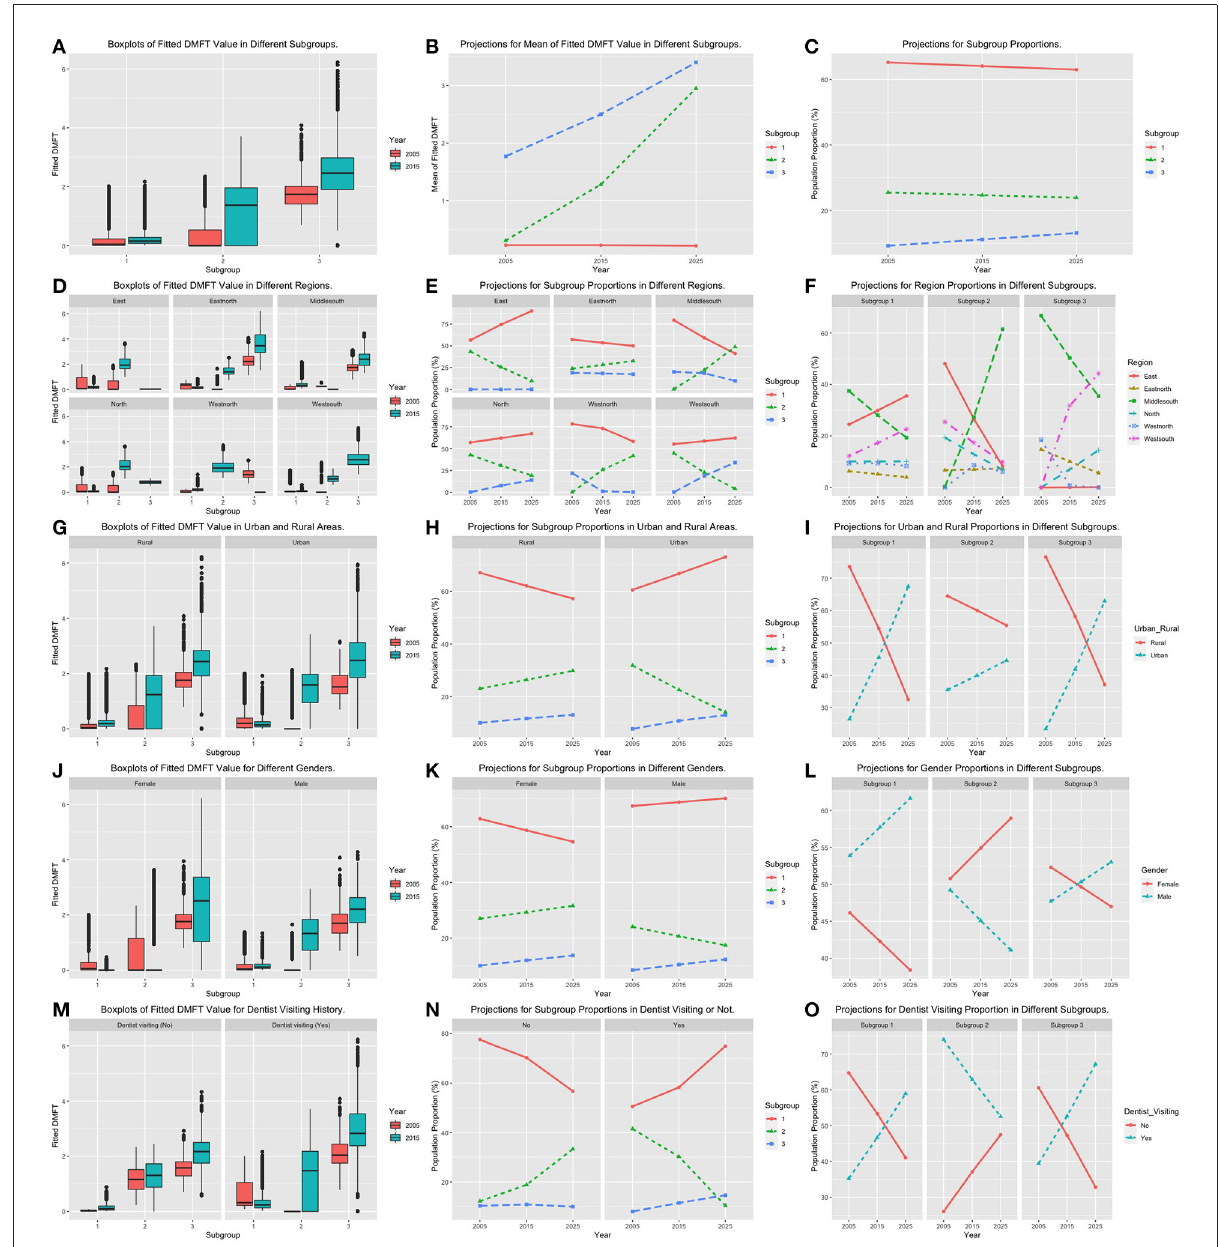
FIGURE1 Boxplots for fitted DMFT, projection plots for subgroup proportions and risk factor category proportions. The first column (A,D,G,J,M) summarizes the boxplots of fitted DMFT values within subgroups by adjusting different risk factors. The second column (B,E,H,K,N) corresponds to the plots of subgroup projections within each risk factor category. The third column (C,F,I,L,O) are plots of risk factor category projection within different subgroups.